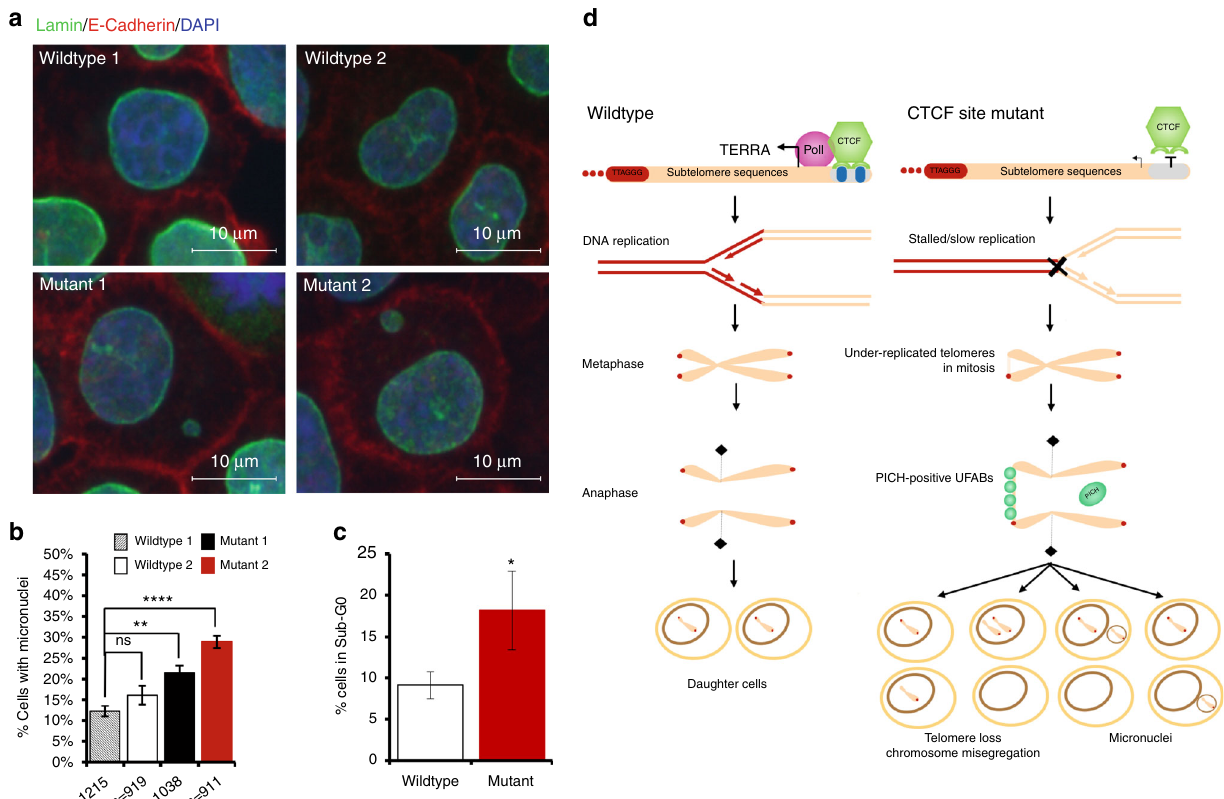
Fig. 6 CTCF site mutant cells exhibit post-mitotic micronuclei and decreased viability. a Wildtype 1 and 2, or Mutant 1 and 2 cells were arrested with thymidine followed by release for 24 h and then stained with Lamin A/C (nuclear membrane) and E-Cadherin (cell membrane) to assess micronuclei formation after mitosis. Representative images of merged channels for each cell type. b Quanti fi cation of a . All IF/FISH experiments represent average of at least 3 biological replicates and SEM. * p < 0.05, ** p < 0.01, and **** p < 0.0001, measured by Student t test. c Cells for wildtype 2 and Mutant 2 were collected 24 h after thymidine release and assessed by fl ow cytometry for sub-G0 cell population. Data represents average of three independent biological replications and SEM, * p < 0.05, by t test. d Schematic depicting effect of CTCF-mediated TERRA transcriptional on telomere replication and